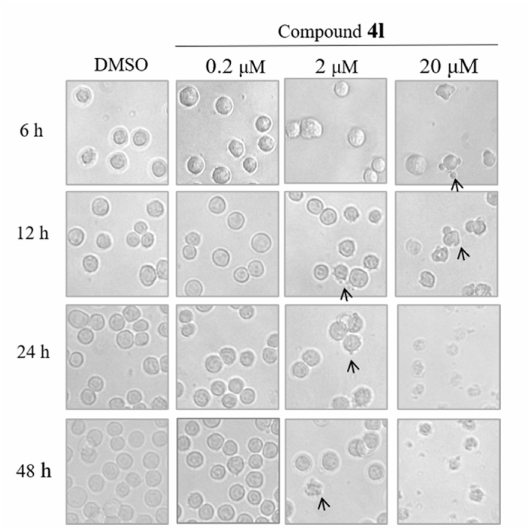
Figure 1. Morphological observation changes in compound 4l treated K562 cells by different concen- tration (0, 0.2, 2, 20 µ M) and different period of time (6, 12, 24, 48